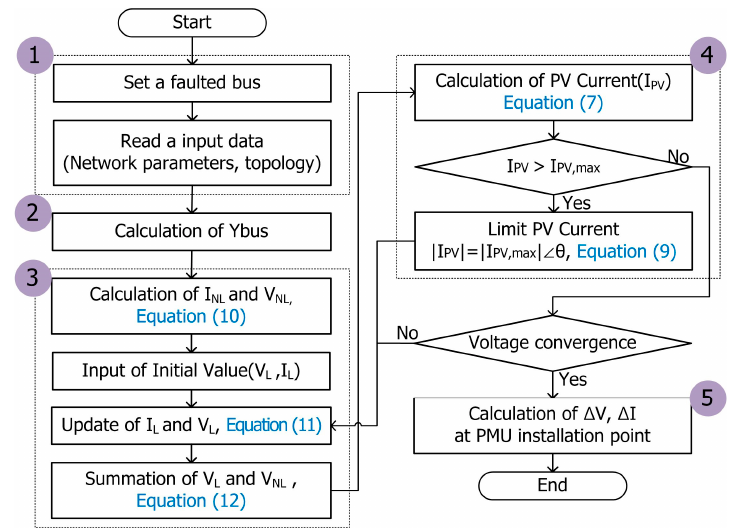
Figure 5. Flowchart of the dynamic fault analysis.